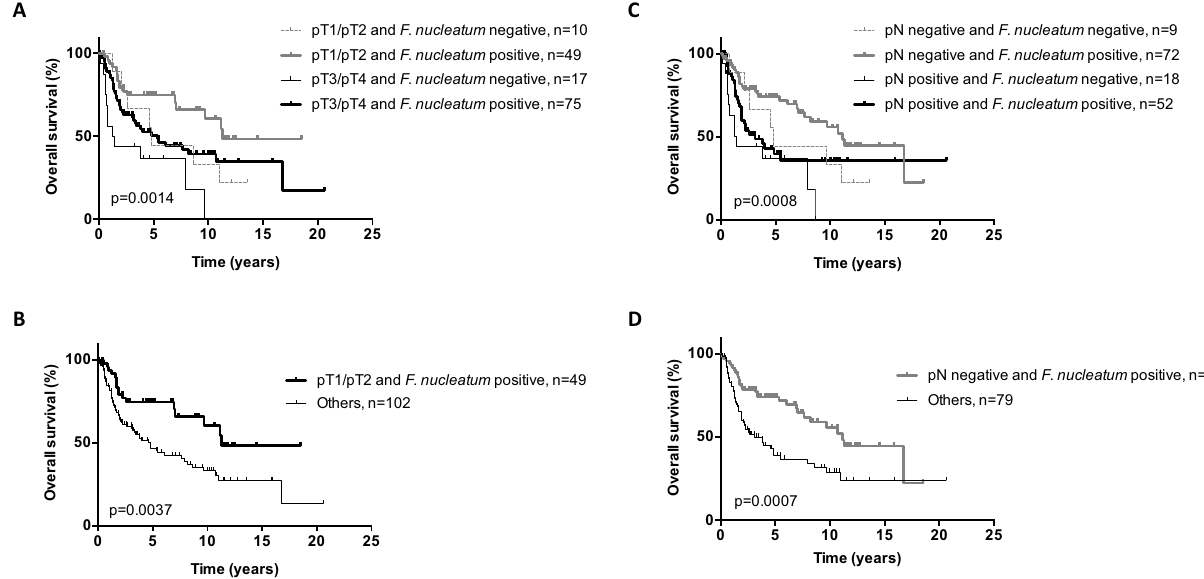
Figure 4. Overall survival (OS) curves according to pT stage and F. nucleatum status ( A , B ) and according to pN stage and F. nucleatum status ( C , D ) in the merged cohort (N = 151).